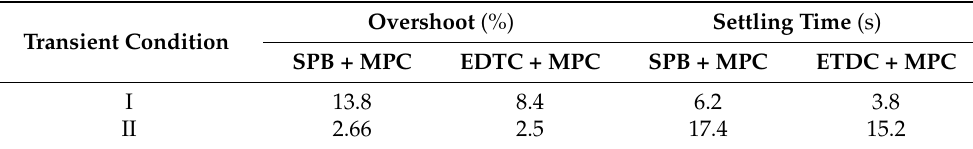
Table 2. Overshoot and Settling Times in the two Transient Conditions Introduced Transient